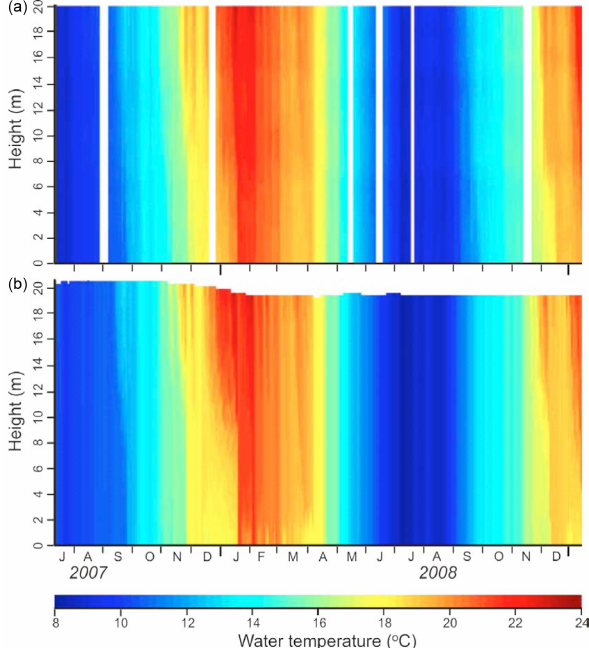
Figure 2. Comparison of observed (a) and simulated (b) water col- umn temperature based on daily data from 13 July 2007–13 January 2009. Height at the y axis represents the water height from the bot- tom.